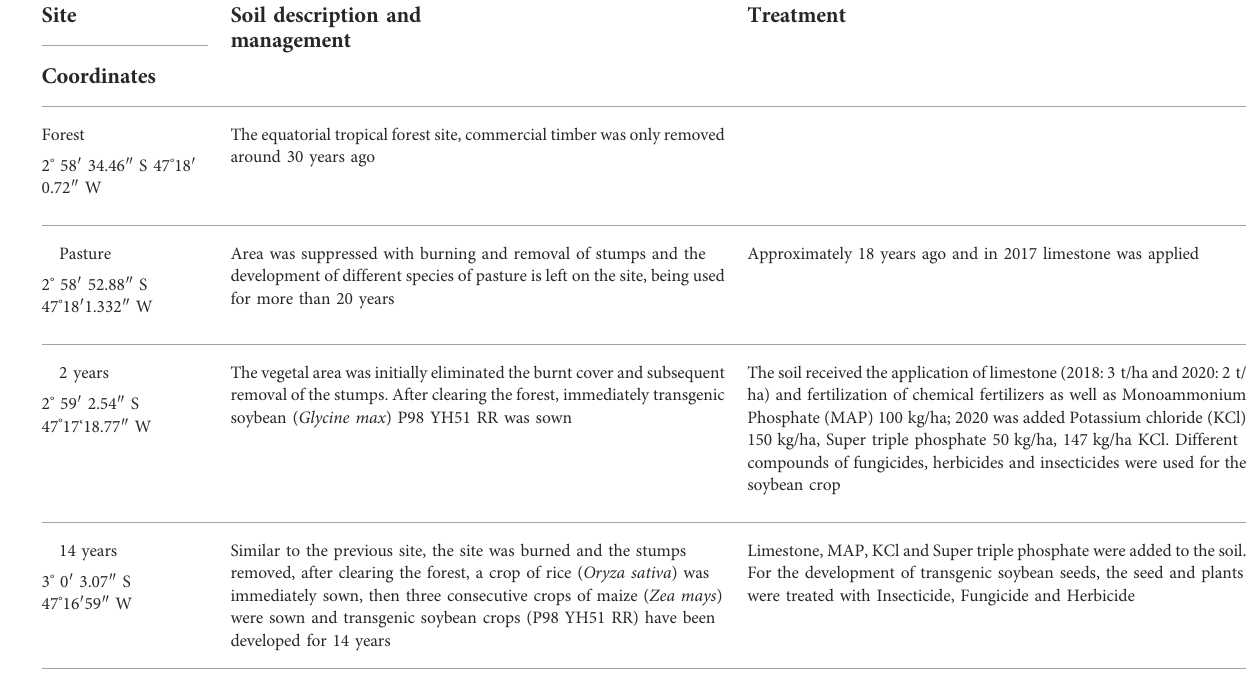
TABLE 1 Description of the characteristics of the sites the samples were